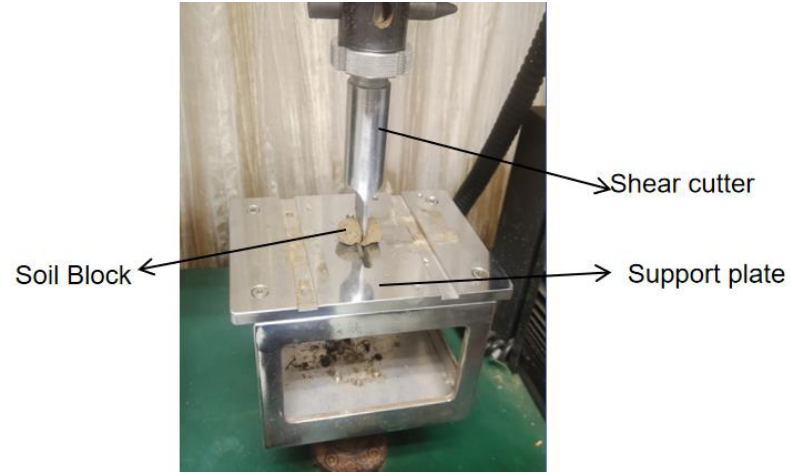
Figure 5. The soil block shear crushing test.